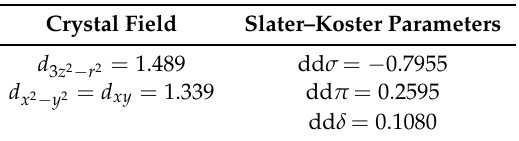
Table 1. List of crystal field energies and Slater–Koster parameters in our model. All values are shown in the unit of